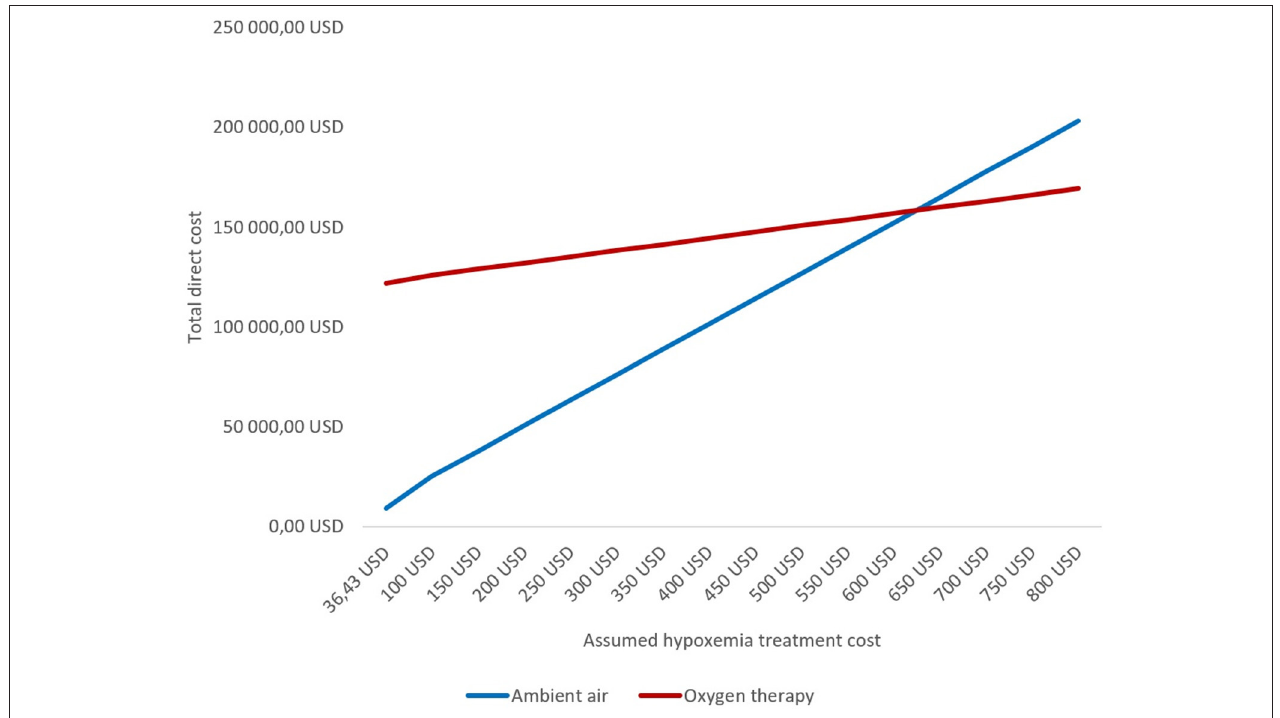
FIGURE 2 | Threshold analysis of total direct cost by varying treatment costs for patients with suspected MI who develop hypoxemia.